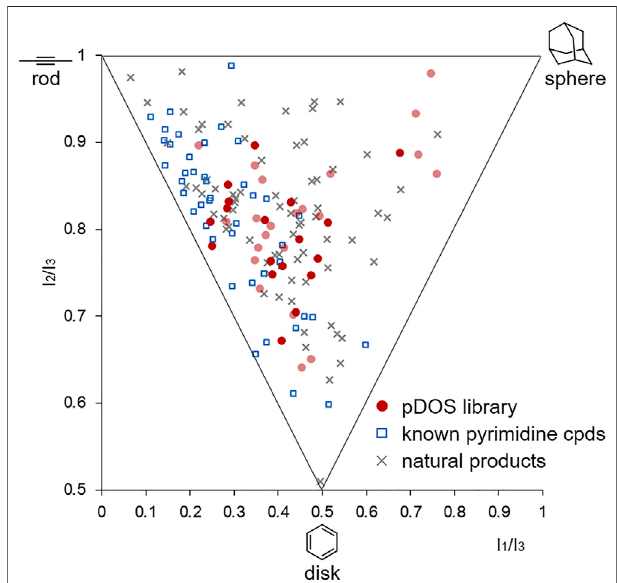
FIGURE 4 | Principal moment of inertia (PMI) plot of natural products, bioactive pyrimidine compounds, and all new molecules synthesized in this study. The 3D molecular shapes of the selected conformers of the newly synthesized compounds (red circles, The dark red circles represent the lowest energy conformers) were compared with reference sets of 45 known bioactive pyrimidine compounds (blue squares) and 60 diverse natural products (grey ×